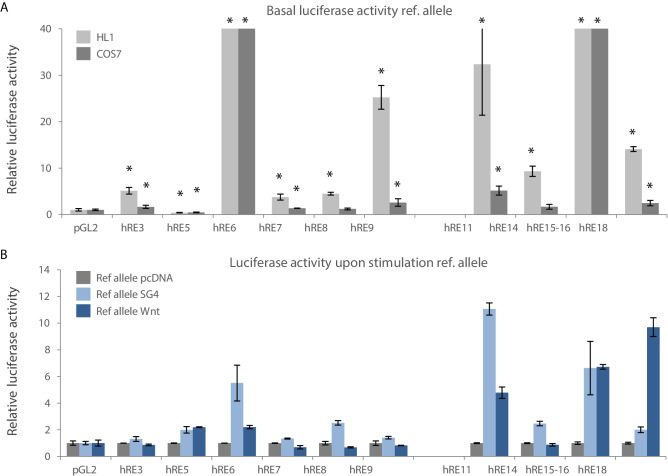
Regulatory activity of RE candidates.(A) Basal activity of reference alleles of RE candidates in HL1 (light grey bars) and COS7 cells (dark grey bars). Luciferase activity for each RE candidate is normalized to the activity of the empty pGL2-SV40 vector. (B) Luciferase activity of reference alleles of RE candidates upon stimulation with Smad/Gata- (SG4) and Tcf+LiCl- (Wnt) factors in COS7 cells. Luciferase activity of each RE candidate is normalized to the activity of each RE candidate upon co-transfection with pcDNA (control). Transfections were performed in duplicates and replicated twice. Error bars represent standard deviation. *: p<0.05.